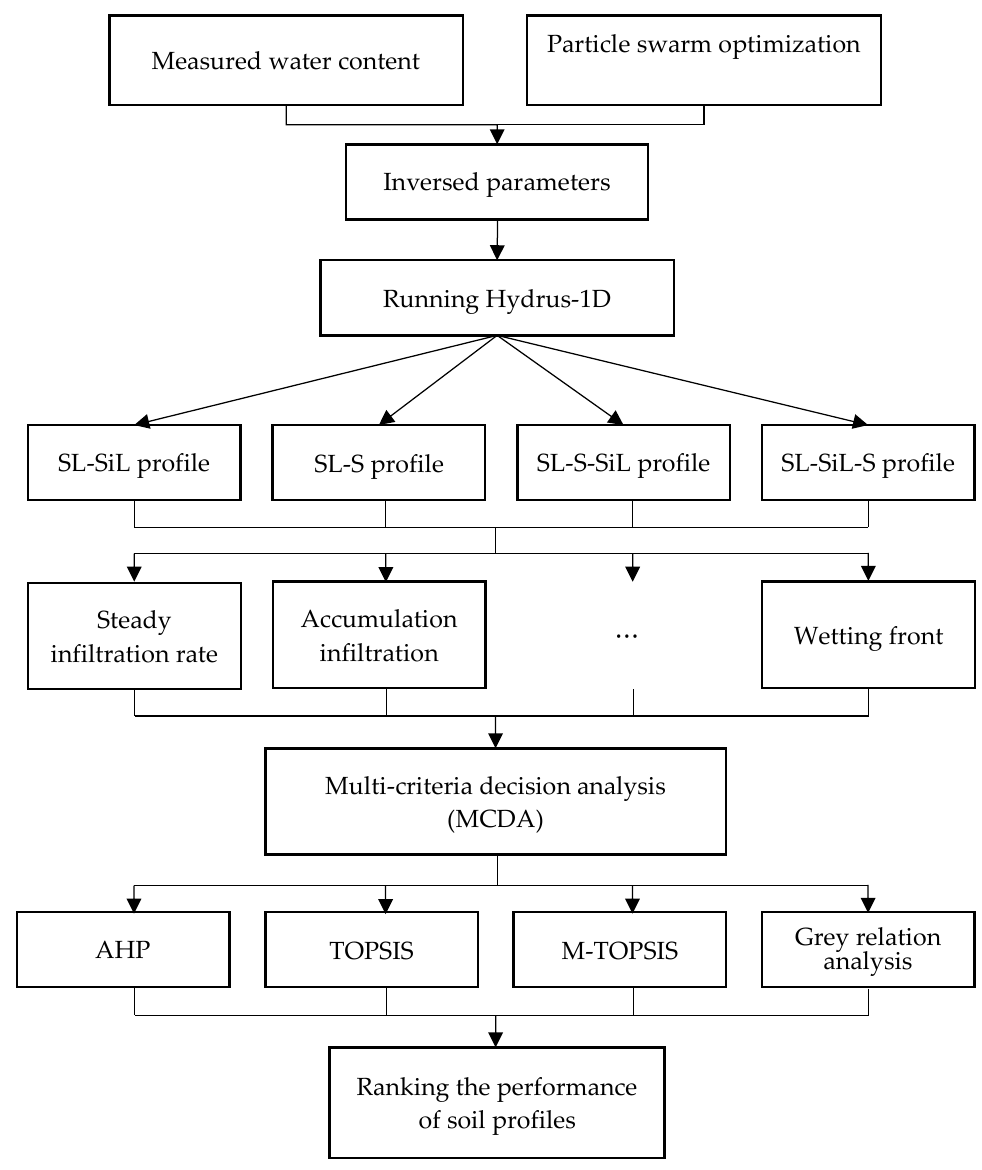
Figure 5. The flowchart of soil profile evaluation.